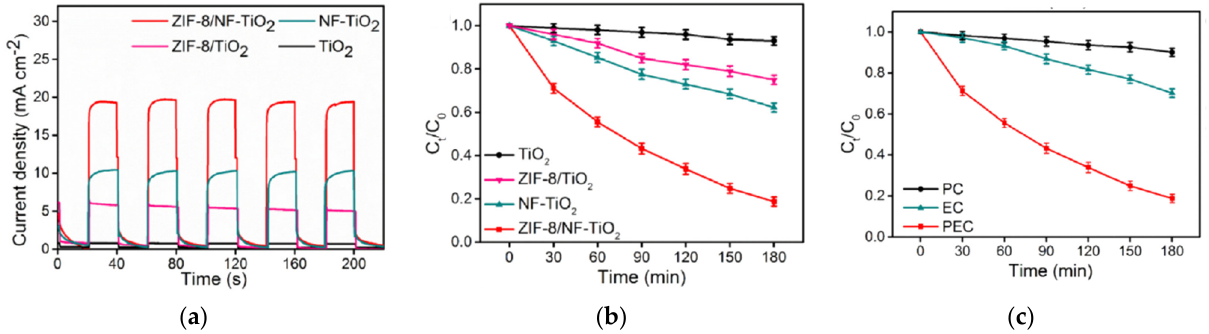
Figure 12. Comparative behavior of pristine TiO 2 , NF-doped TiO 2 , ZIF-8 modified TiO 2 , and ZIF-8 modified NF-TiO 2 . ( a ) Photocurrent response, ( b ) photoelectrocatalytic abatement of sulfamtheoxazole by PEC, ( c ) comparative performance between photocatalysis (PC), electrocatalysis (EC), and PEC. Adapted from